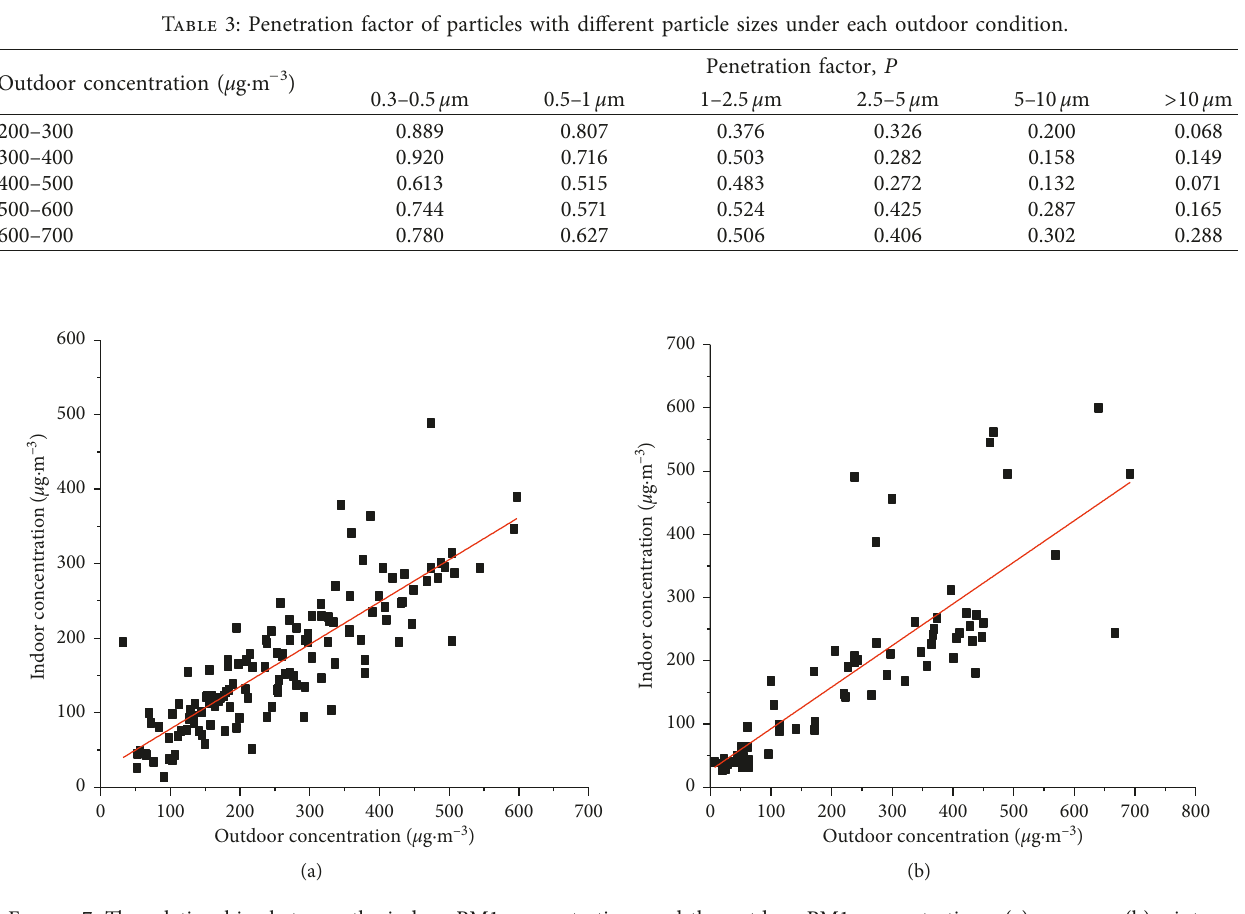
Figure 7: The relationships between the indoor PM1 concentrations and the outdoor PM1 concentrations: (a) summer; (b) winter.